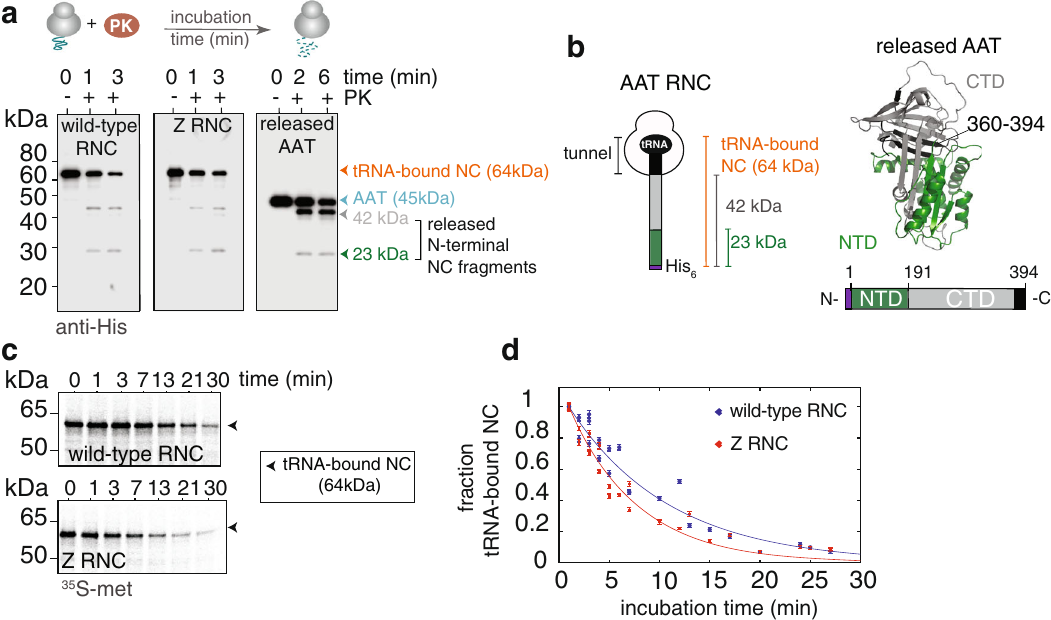
Fig. 3 Wild-type and Z AAT ribosome-nascent chain complexes (RNC) can adopt co-translational structure. a A schematic of the proteinase K limited proteolysis experiment (upper). Limited proteolysis of wild-type and Z puri fi ed RNCs (orange arrowhead), and puri fi ed, released wild-type AAT (blue arrowhead) monitored by an anti-His western blot (lower). Highlighted are two N-terminal proteolytic products released from the nascent chain segment emerged from the ribosome: 42 kDa (grey arrowhead) and 23 kDa (green arrowhead). b Schematic of an AAT RNC highlighting the N-terminal fragments observed in a (left). (right) Structure of AAT and schematic representation of (released) AAT showing the boundaries of the N-terminal (NTD, green) and C-terminal (CTD, grey) sub-domains, and C-terminal residues 360 – 394 which are occluded in the ribosomal tunnel within the RNC (see left). The segment of structure shown in black is the 35 amino acid stretch that is occluded in the tunnel when full-length AAT is bound to the ribosome. c Proteinase K limited proteolysis measured over time for wild-type and Z RNCs, highlighting the measurement of the intact tRNA-bound nascent chain (NC) over time using 35 S-methionine detection and partially-denaturing PAGE ( n = 3 biological repeats). See also Supplementary Fig. 2. d Densitometric analysis of